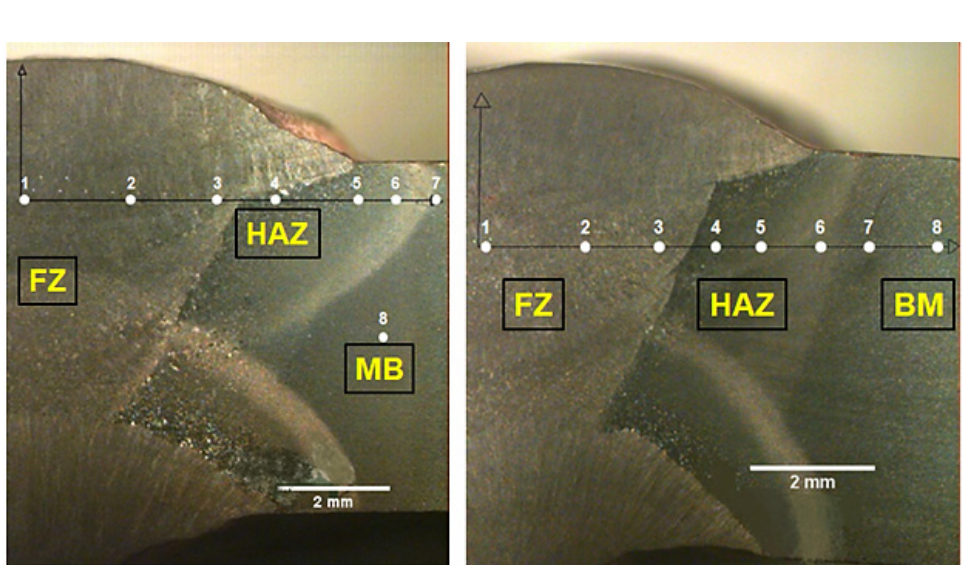
Figure 11. Microhardness numbered points (white) in the etched transversal section of the welded HHA steel, from the center of FZ to BM, across the HAZ. Minimum of 5 measurements per point.